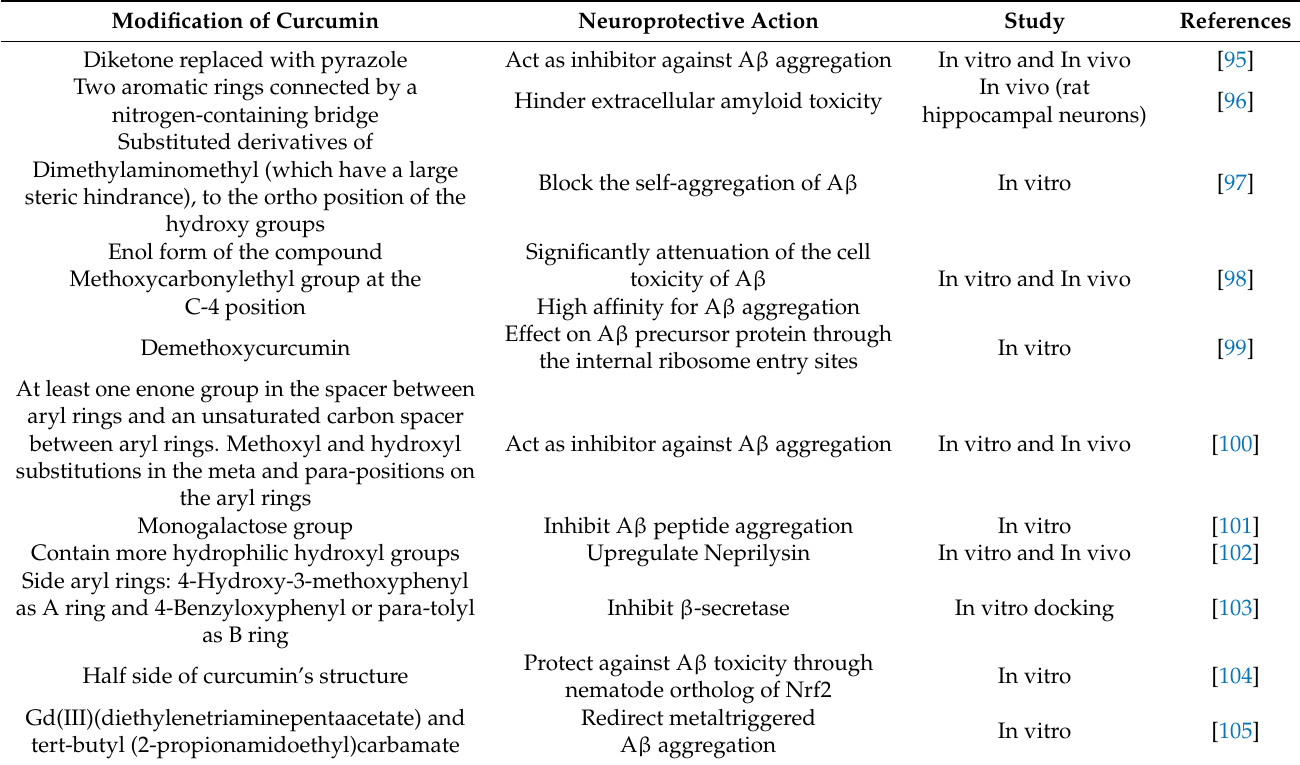
Table 1. Modified curcumin’s structure and their possible role against Alzheimer’s